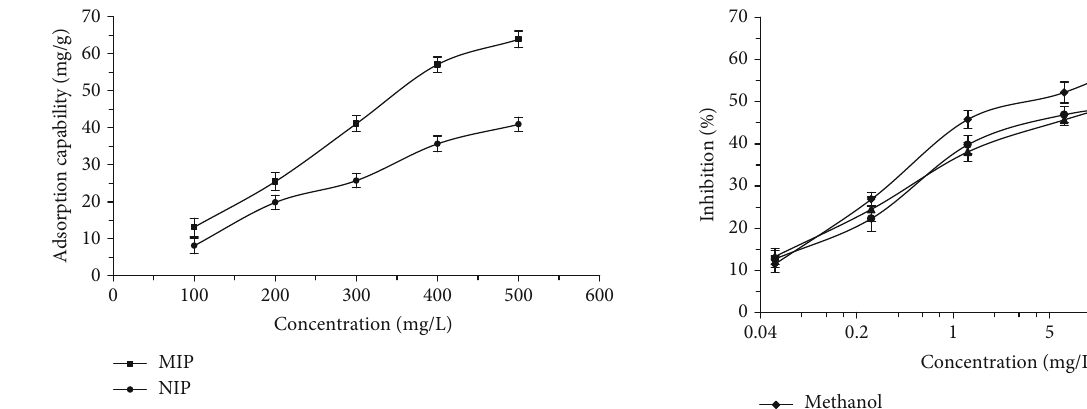
Figure 1: Adsorption isotherms of the imprinted and nonimprinted polymers.